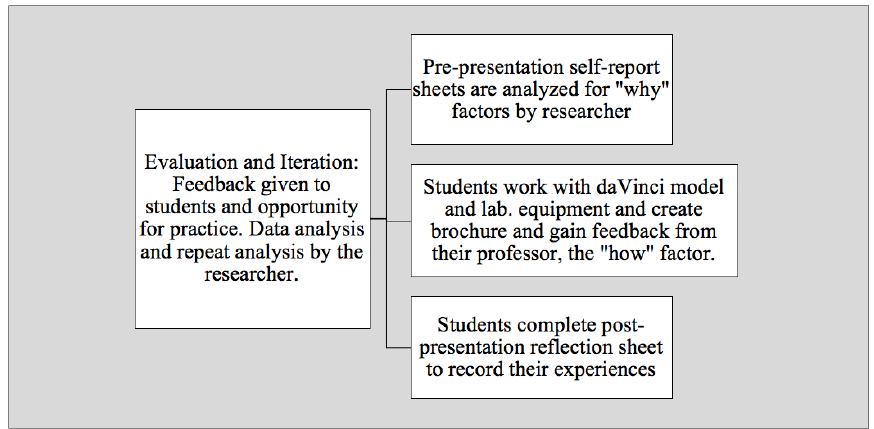
Fig. 3. The pedagogic model illustrates the three elements of preparation and data analysis with opportunities for feedback and evaluation as well as